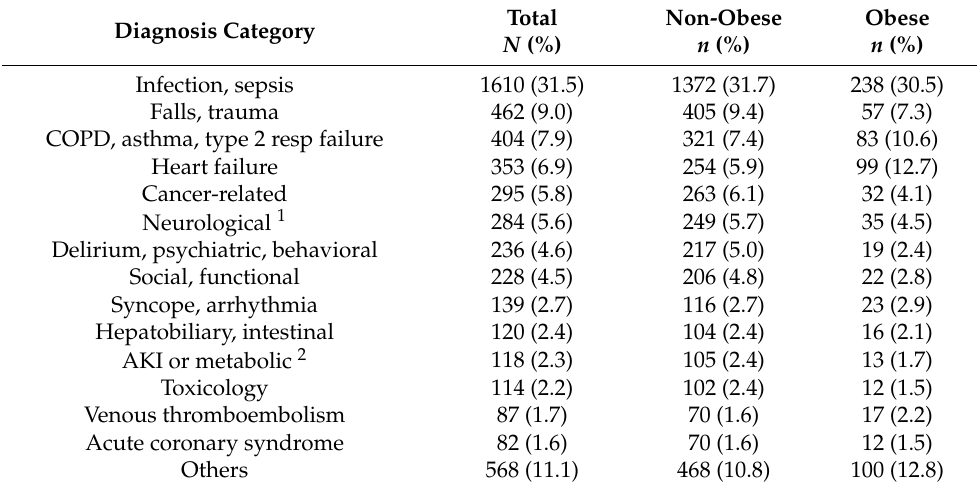
Table 3. Primary diagnosis for medical admission in order of frequency.